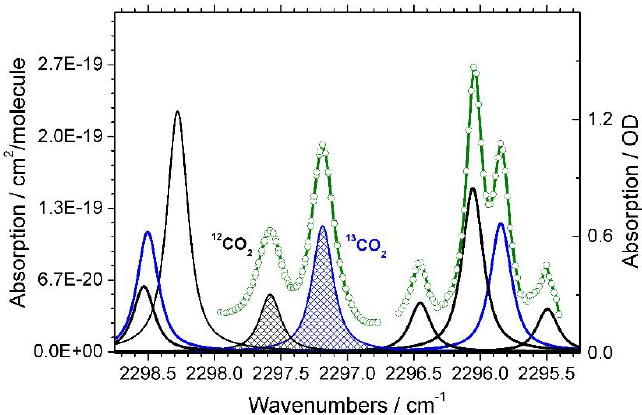
Figure 3. Selected spectral window and simulated positions of 12 CO 2 (black lines) and 13 CO 2 (blue lines) absorption. Left scale: Absorption in cm 2 per molecule as a function of wavenumber. Positions and absorption/extinction coefficients were taken from the HITRAN (High Resolution Transmission) database for a simulated linewidth of 0.19 cm −1 (FWHM) Right scale: Detected absorption in optical density OD (without units) according to Lambert Beer law (green circles and lines, right scale).